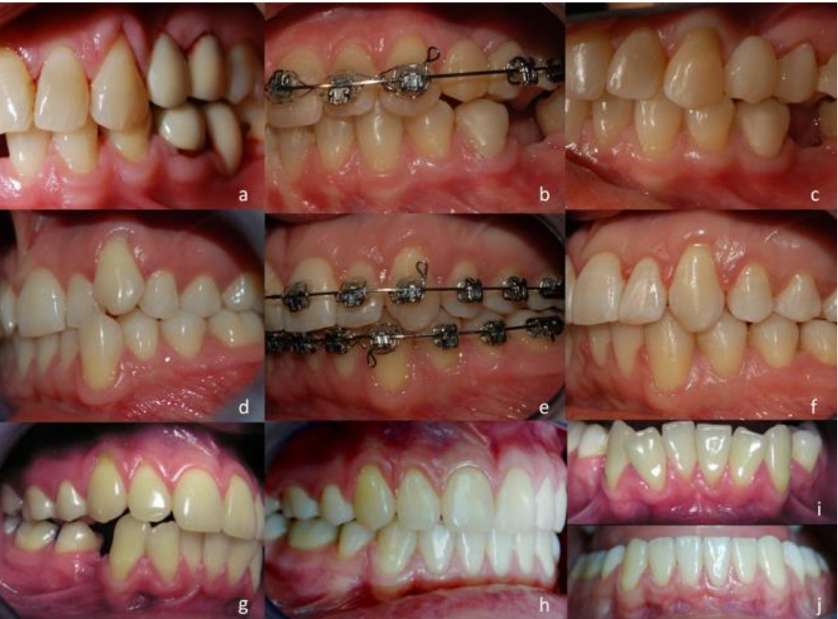
Figure 7. ( a – c )—change of gingival recession when deep traumatic contact of tooth 23 was corrected by intrusion; ( d – f )—no significant change of gingival recession of tooth 23 before, during and after orthodontic treatment; ( g – j )—change of gingival recessions before and after orthodontic treatment of maxillary and mandibular anterior teeth due to more favorable centered position in the middle of alveolar bone.